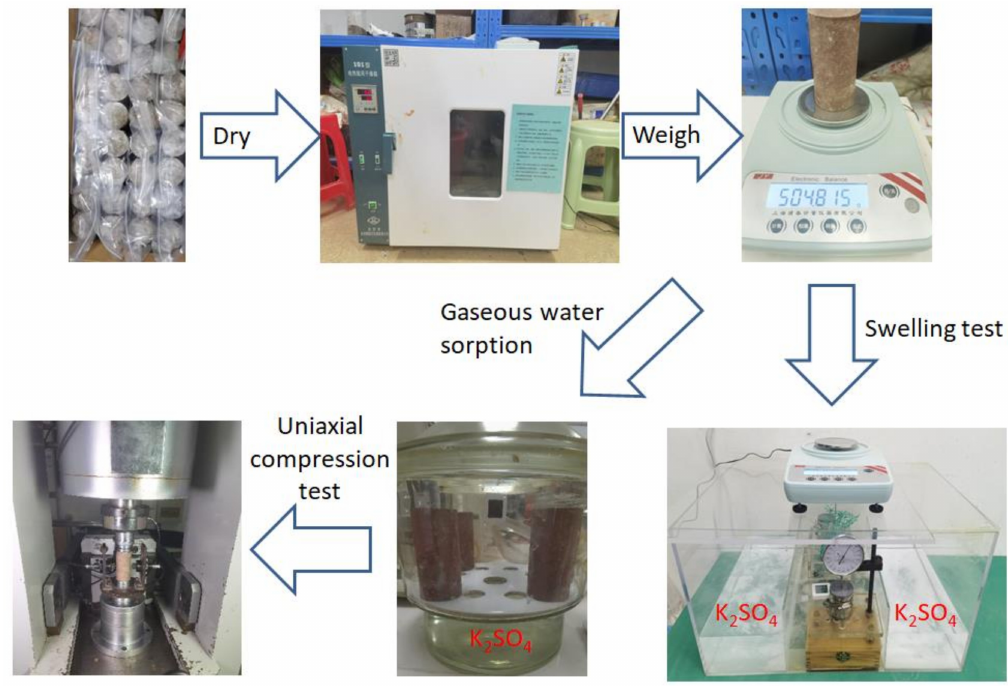
Figure 2. The processing of tests.